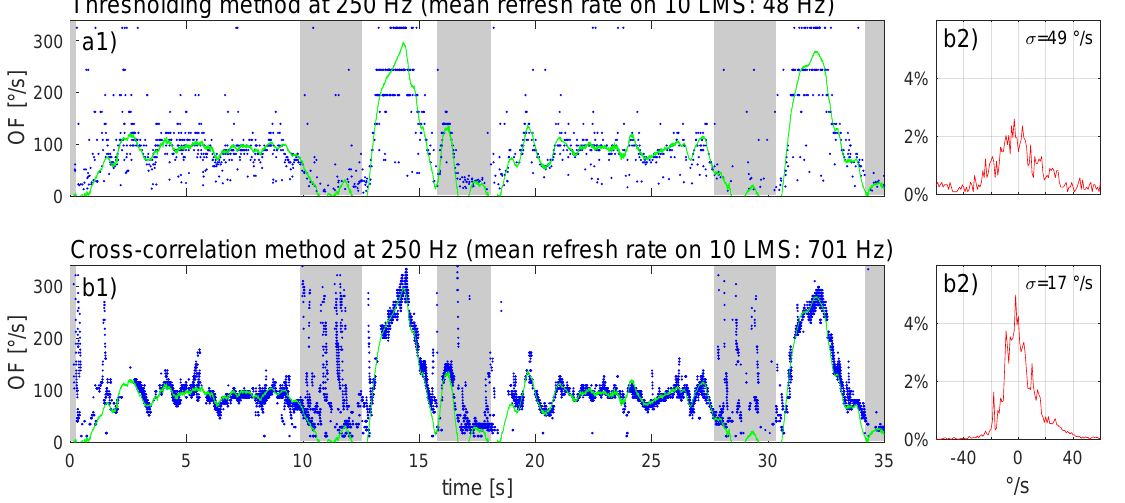
Figure 10. OF computed with ( a ) the thresholding method and ( b ) the cross-correlation method after down-sampling the data underlying Figure 9 to F e = 250Hz.